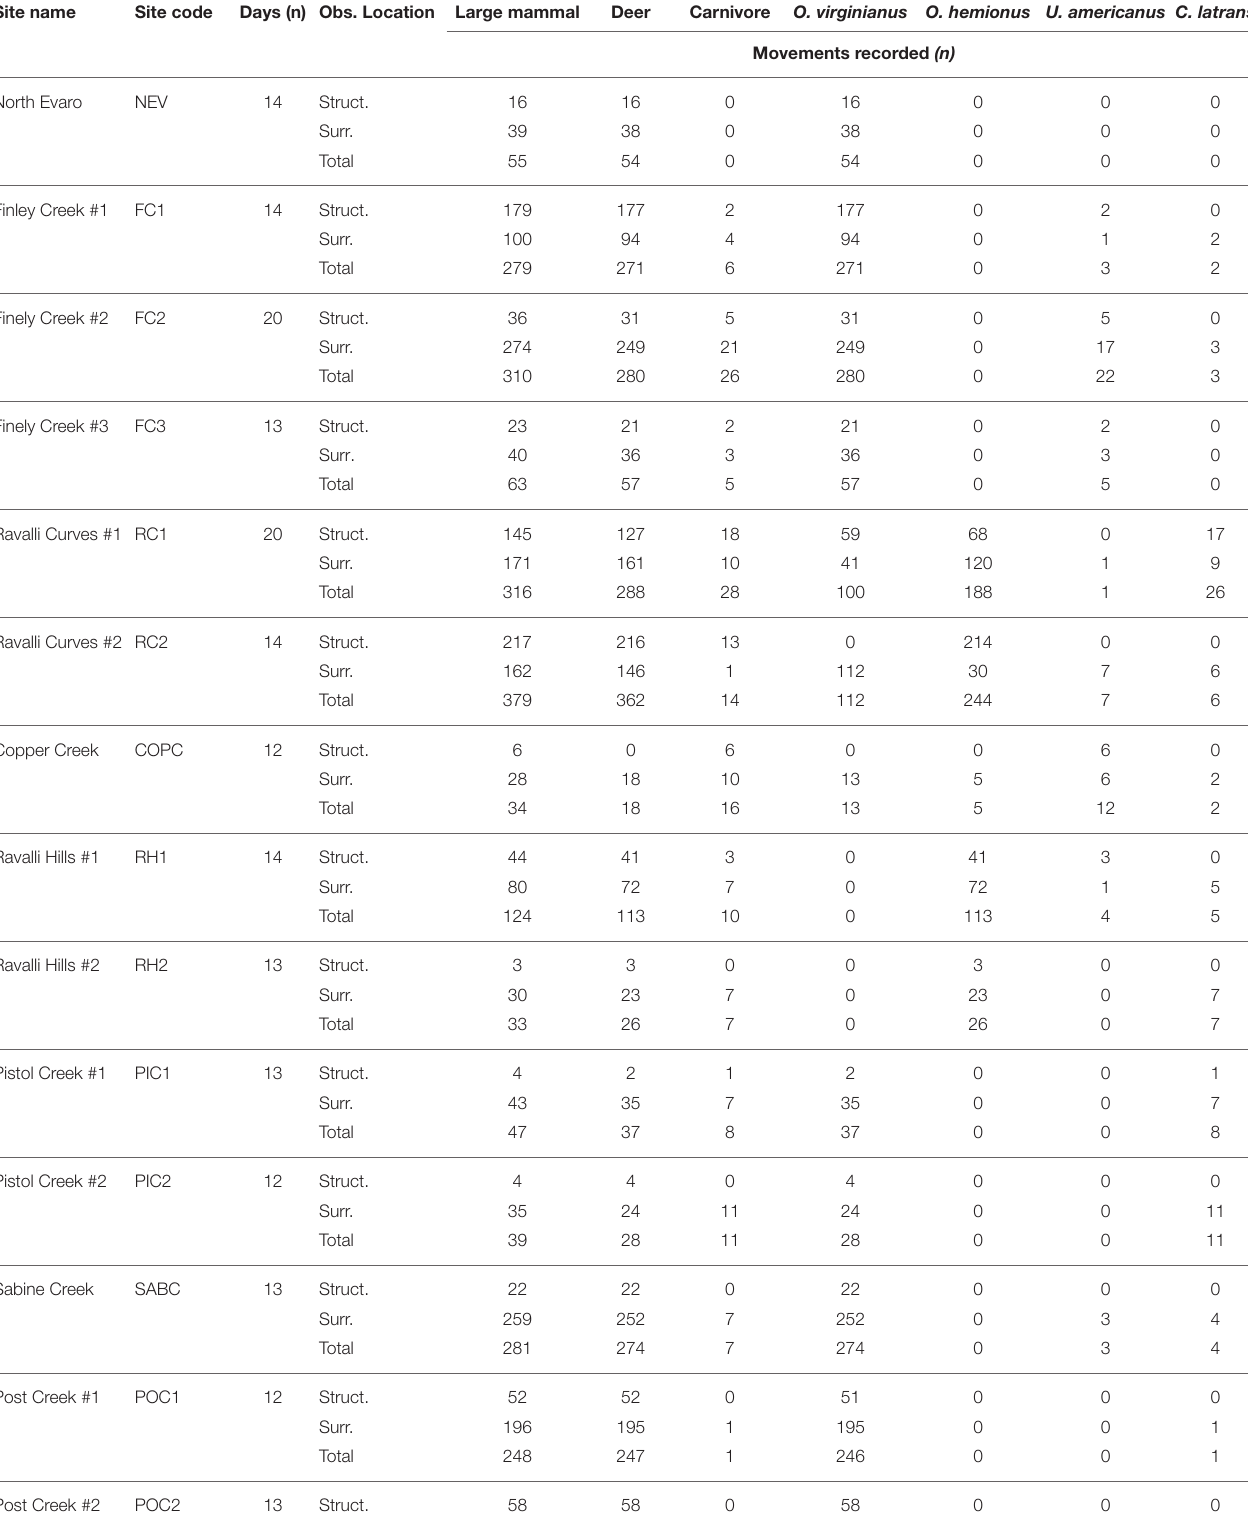
TABLE 2 | Details on animal movements observed at underpass sites and number of full, 24-h days recorded at each